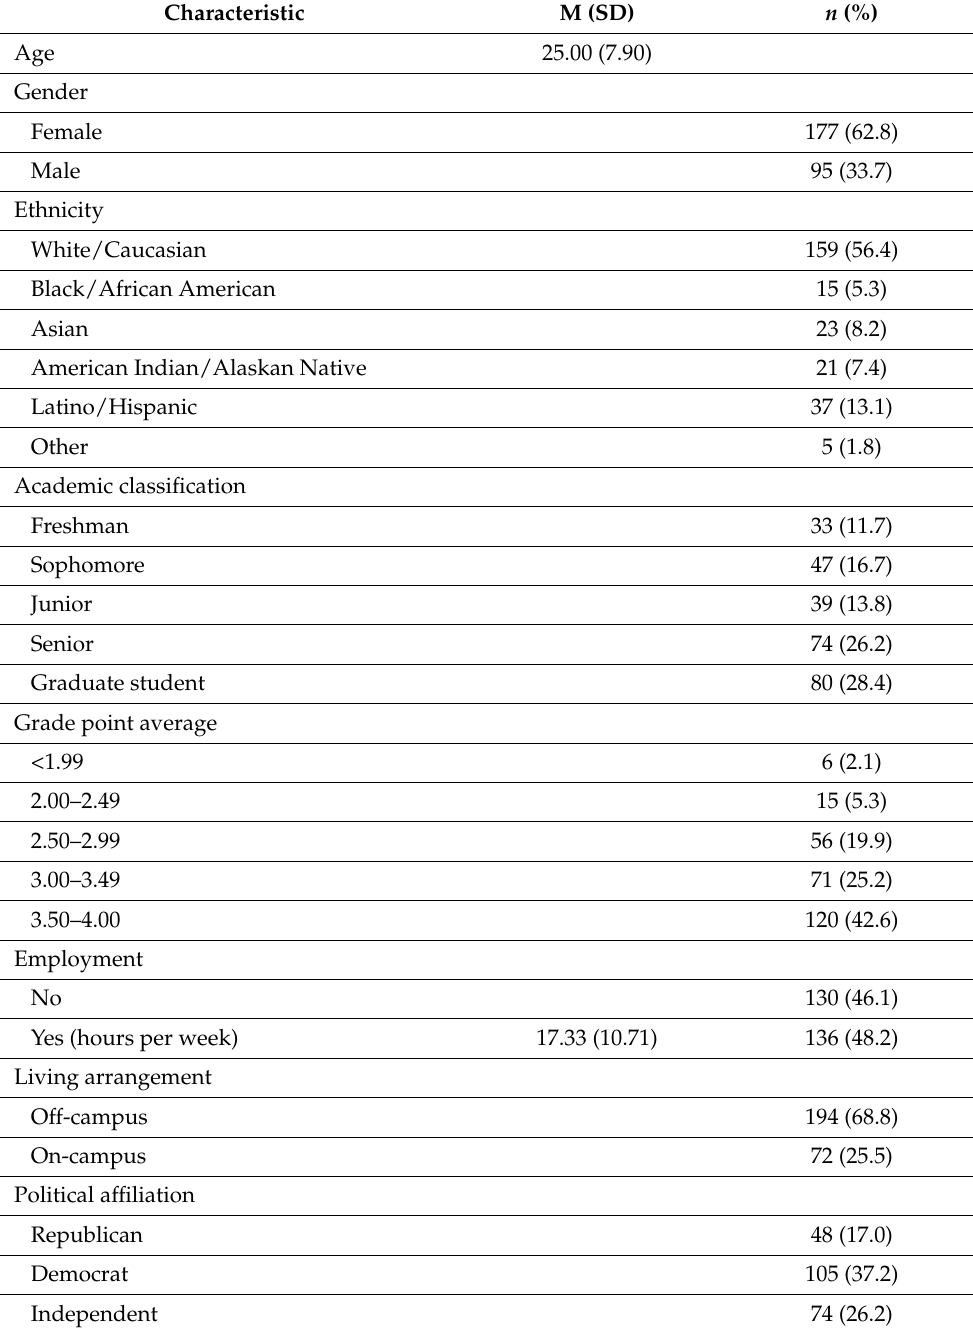
Table 1. Descriptive characteristics of the study sample ( n = 282)